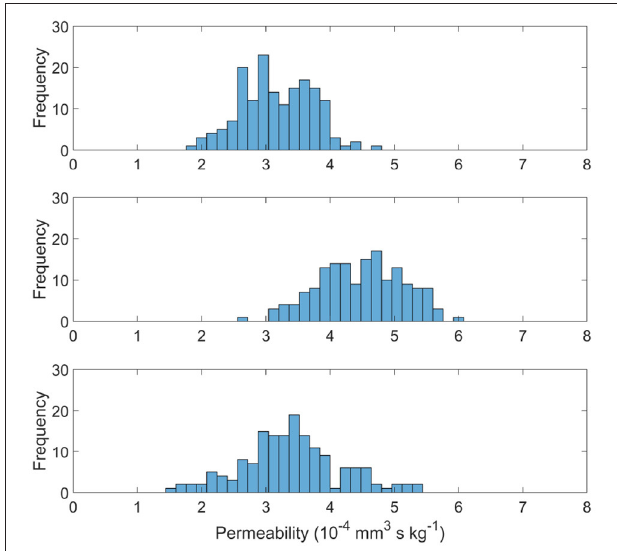
FIGURE 6 | Permeability distributions for young (top) , middle aged (middle) , and old (bottom) capillary networks.